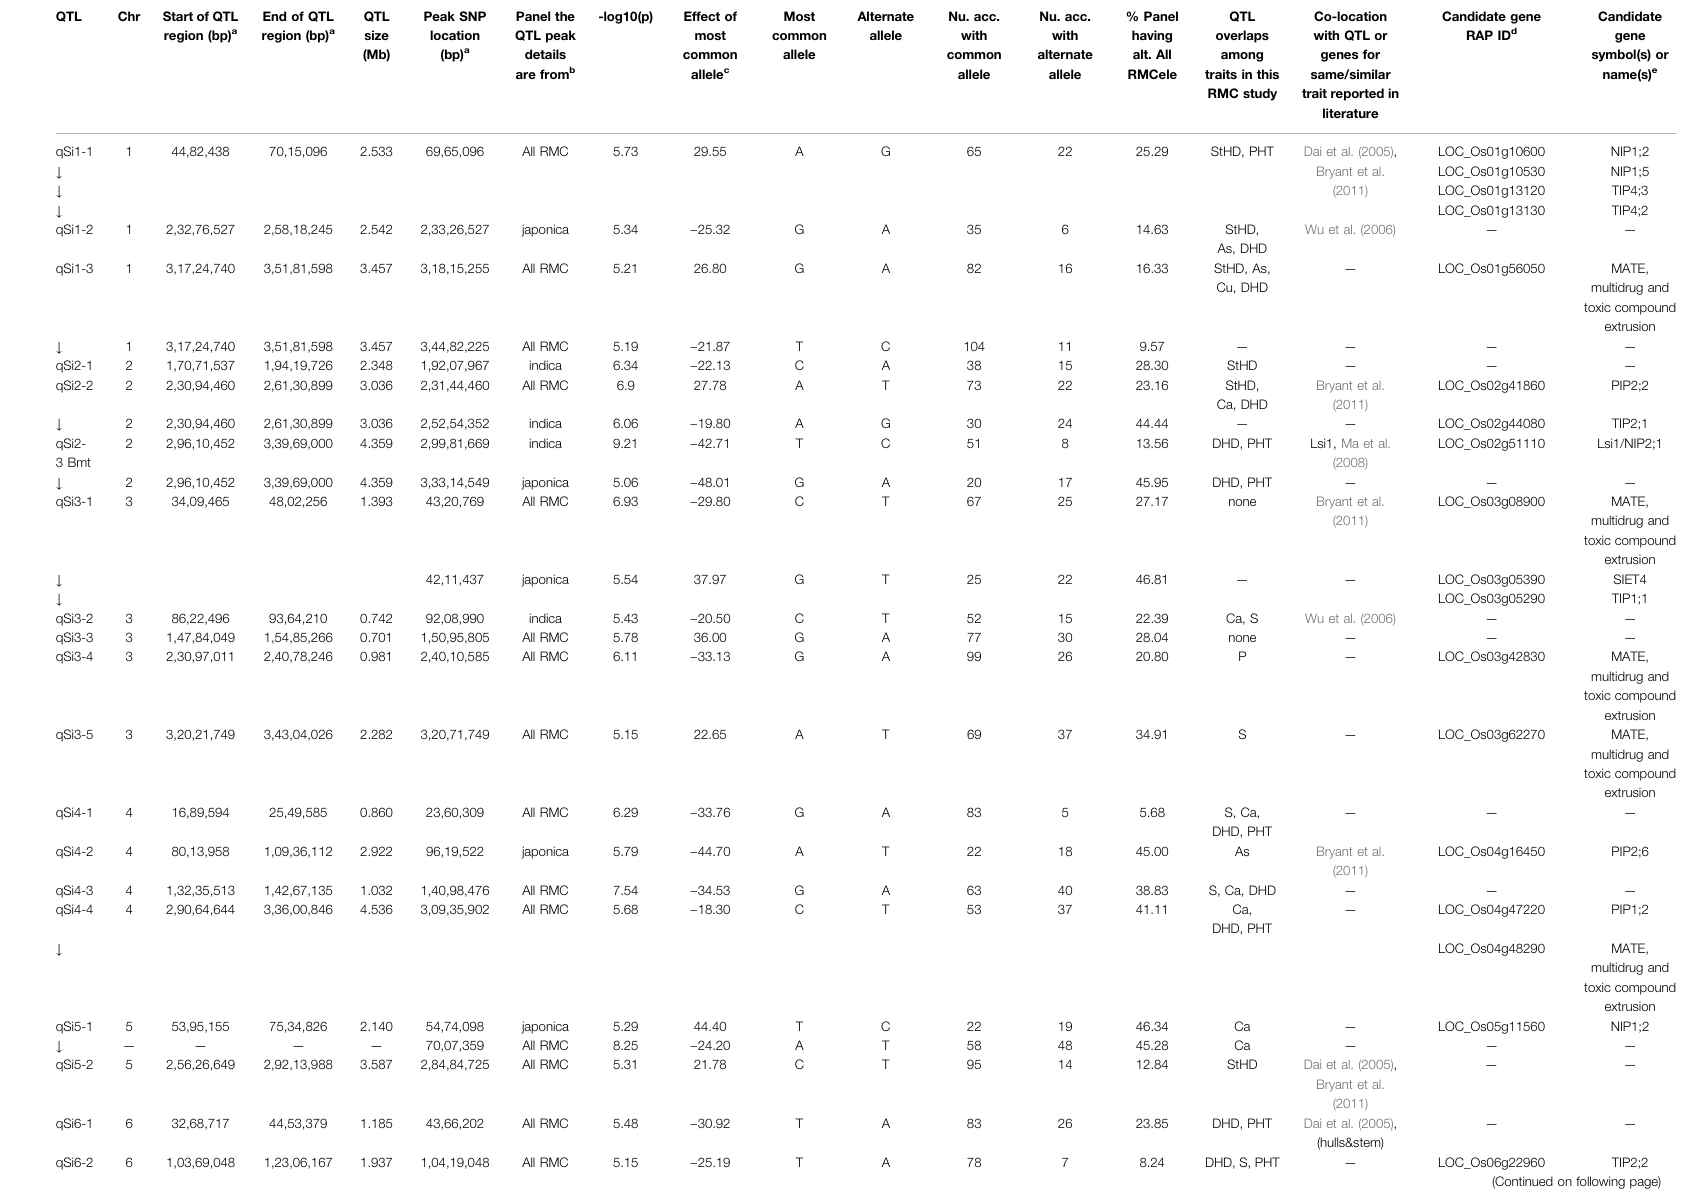
TABLE 2 | QTL associated by GWA with hull-Si concentration (qSi) in the Rice Minicore Panel (RMC) arranged in chromosomal order.